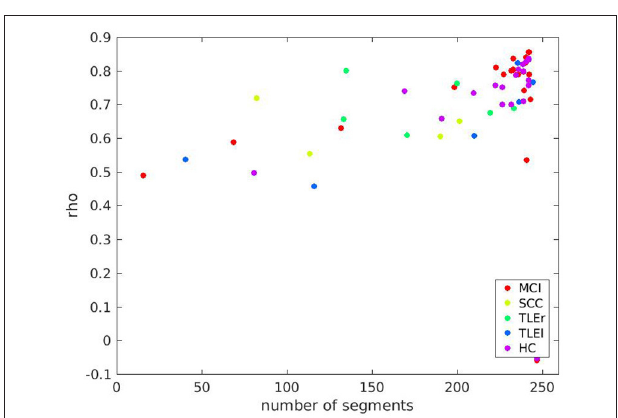
FIGURE 7 | Scatter plot of test-retest reliabilities for full frequency transfer function vs. number of clean segments of size 500 ms. Calculation of test-retest reliabilities was based on segments without artifacts, only. The x-axis represents the average number of segments across two sessions included in the analysis. Colors indicate groups MCI, mild cognitive impairment; SCC, subjective cognitive complaints; TLEr, temporal lobe epilepsy with focus on the right hemisphere; TLEl, temporal lobe epilepsy with focus on the left hemisphere; HC, healthy